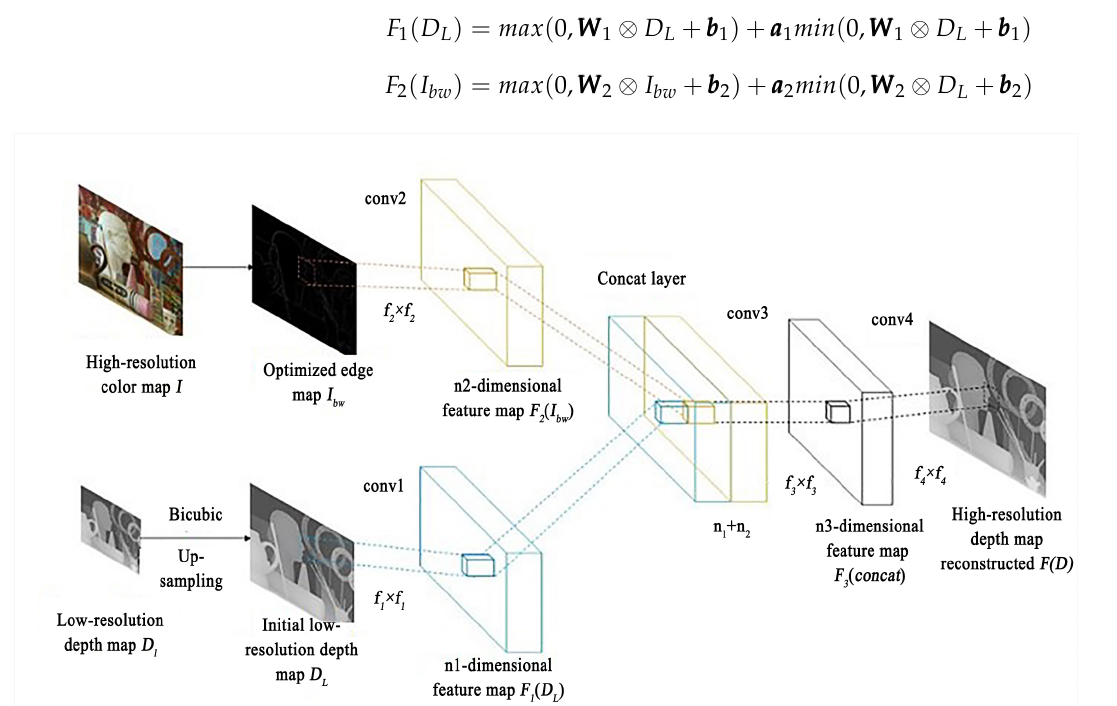
Figure 2. CNN for Super-Resolution